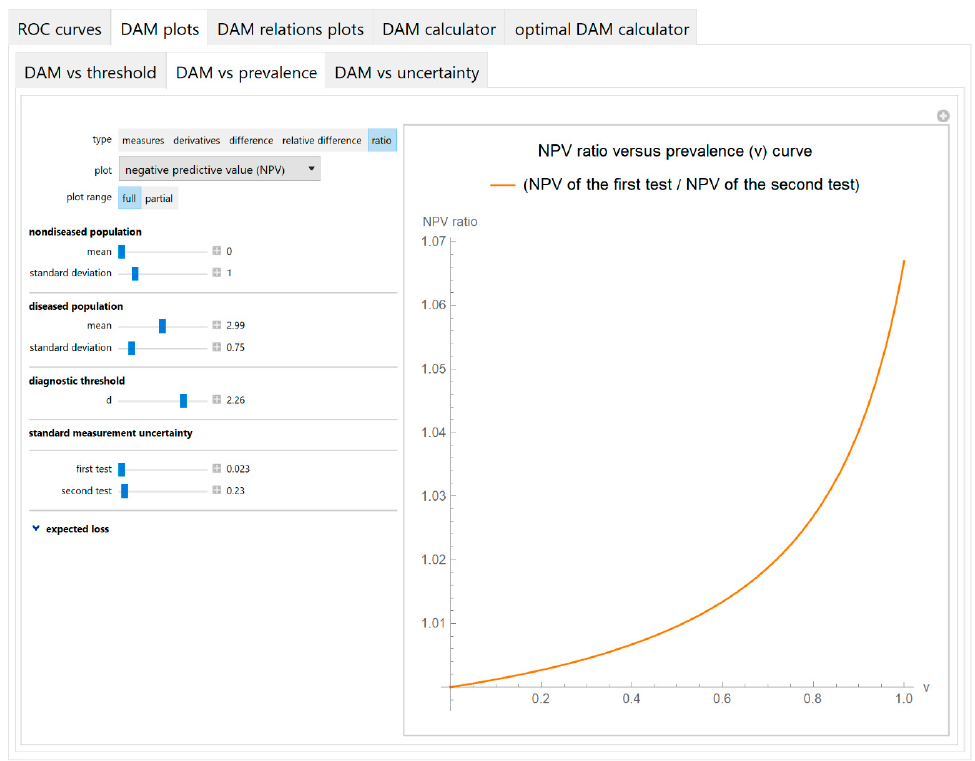
Figure 4. DAM plots module, DAM against threshold submodule screenshot. Ratio of the risk ( R ) of two screening or diagnostic tests measuring the same measurand with different uncertainties, against diagnostic threshold ( d ) curve plot, with the settings at the left.